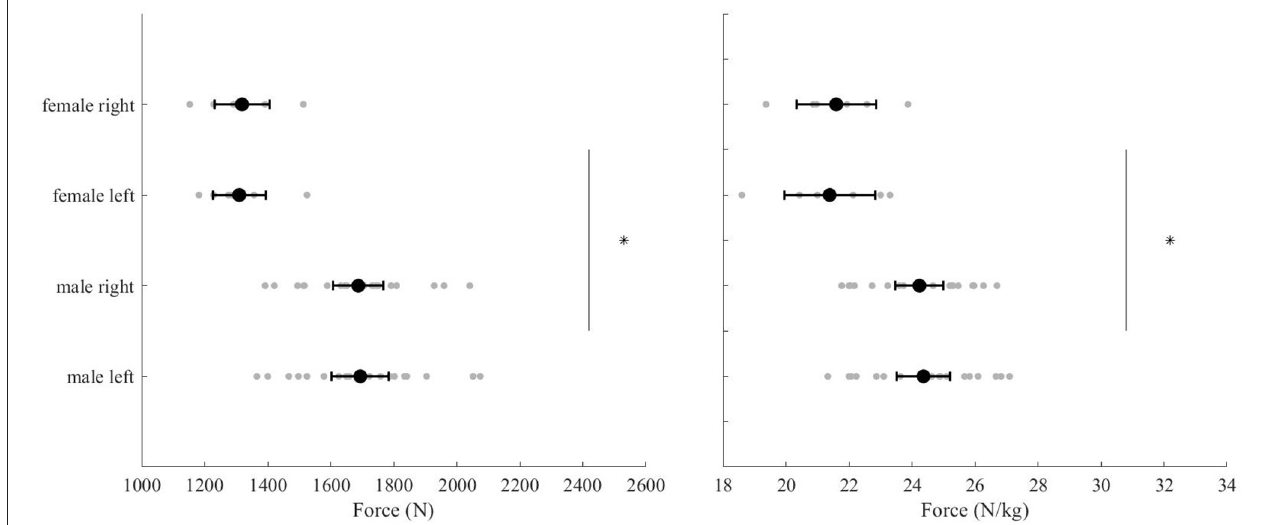
FIGURE 2 | PF abs values (left) for left and right limbs in male and female freeski athletes. Relative PF values (right) for left and right limbs for male and female freeski athletes. Data are shown as mean ( 95% confidence intervals) and individual data (gray dots). *Represents a significant difference between male and +